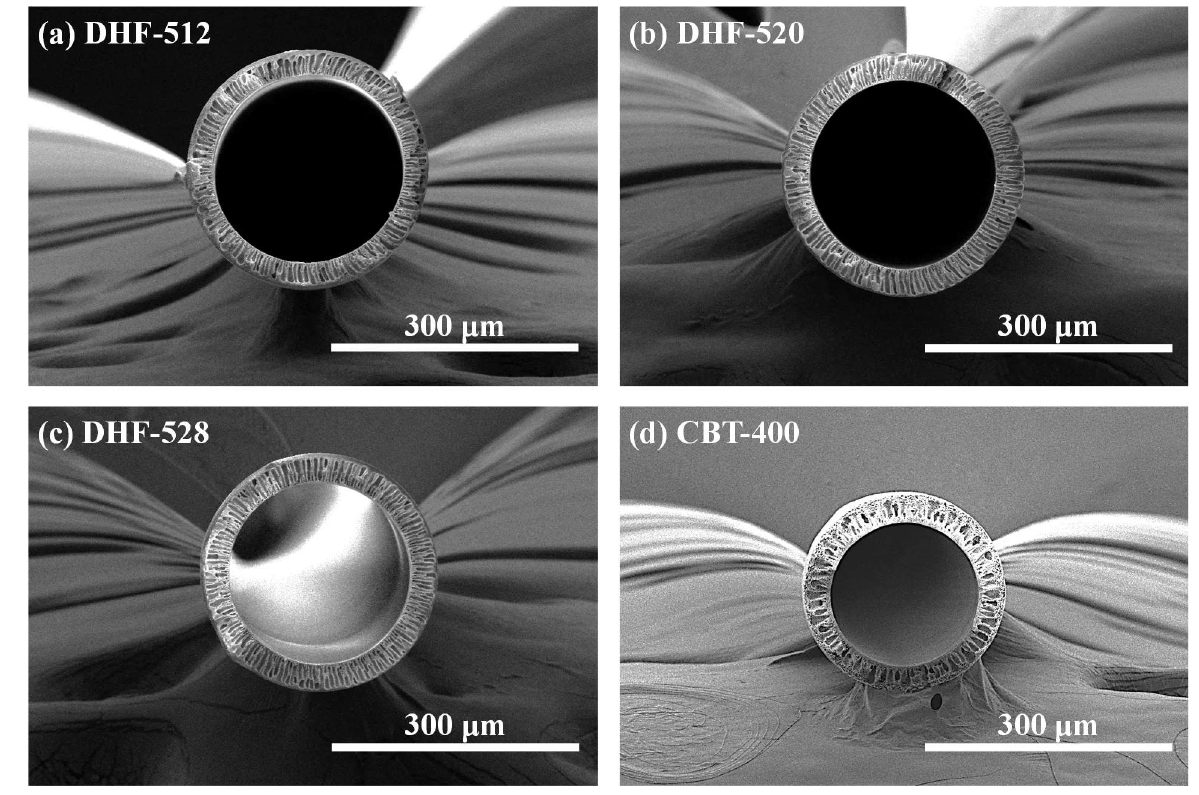
Figure 3. Cross-sectional images of DHFs and CHF, ( a ). 12 wt.% of PEG content HF referred to DHF-512, ( b ). 20 wt.% of PEG content HF referred to DHF-520, ( c ). 28 wt.% of PEG content HF referred to DHF-528 ( c ), and CHF ( d ).